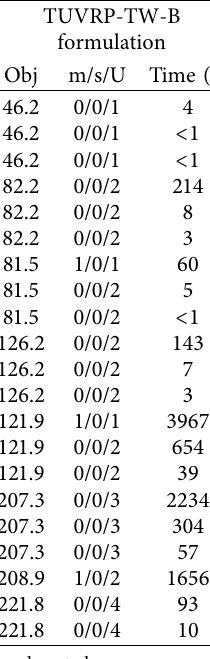
Table 3: Exact solutions for small-scale